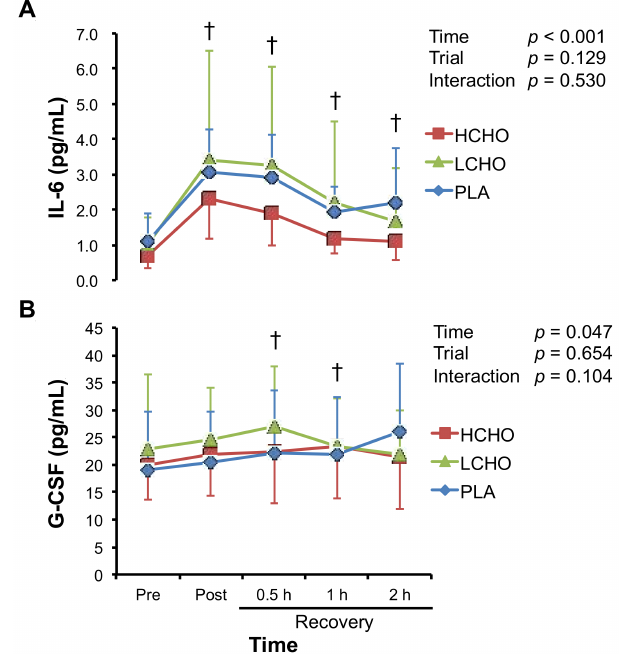
Figure 2. Changes in plasma interleukin-6 (IL-6) ( A ) and granulocyte colony-stimulating factor (G-CSF) ( B ) concentrations in response to endurance exercise. HCHO, high-carbohydrate trial; LCHO, low-carbohydrate trial; PLA, placebo trial; Pre, pre-exercise; Post, immediately after exercise; 0.5 h, 0.5 h after exercise; 1 h, 1 h after exercise; 2 h, 2 h after exercise. † p < 0.05 vs.